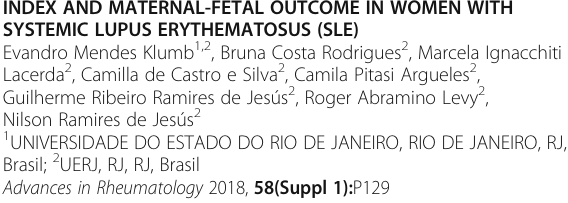
CORRELATION BETWEEN CAPILLAROSCOPY PATTERNS AND AUTOANTIBODY PROFILES IN SYSTEMIC SCLEROSIS PATIENTS